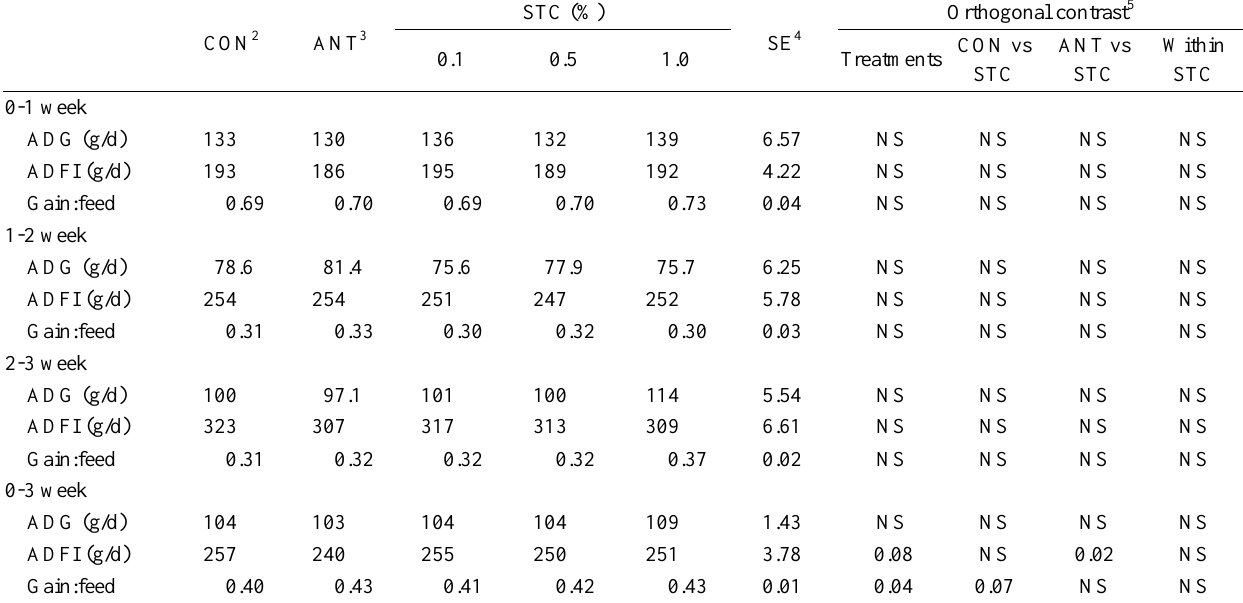
1 Values represent the means of six pens with five ducklings per pen. 2 CON = Control. 3 ANT = Antibiotic. 4 Pooled standard error of the LS Means. 5 Orthogonal contrast (tendency: p<0.10; significant: p<0.05) are treatments = Control vs other diets (Diet 4 -1 -1 -1 -1); CON vs STC (Diet 3 0 -1 -1 -1); ANT vs STC (Diet 0 -3 1 1 1), Within STC (Diet 0 0 2 -1